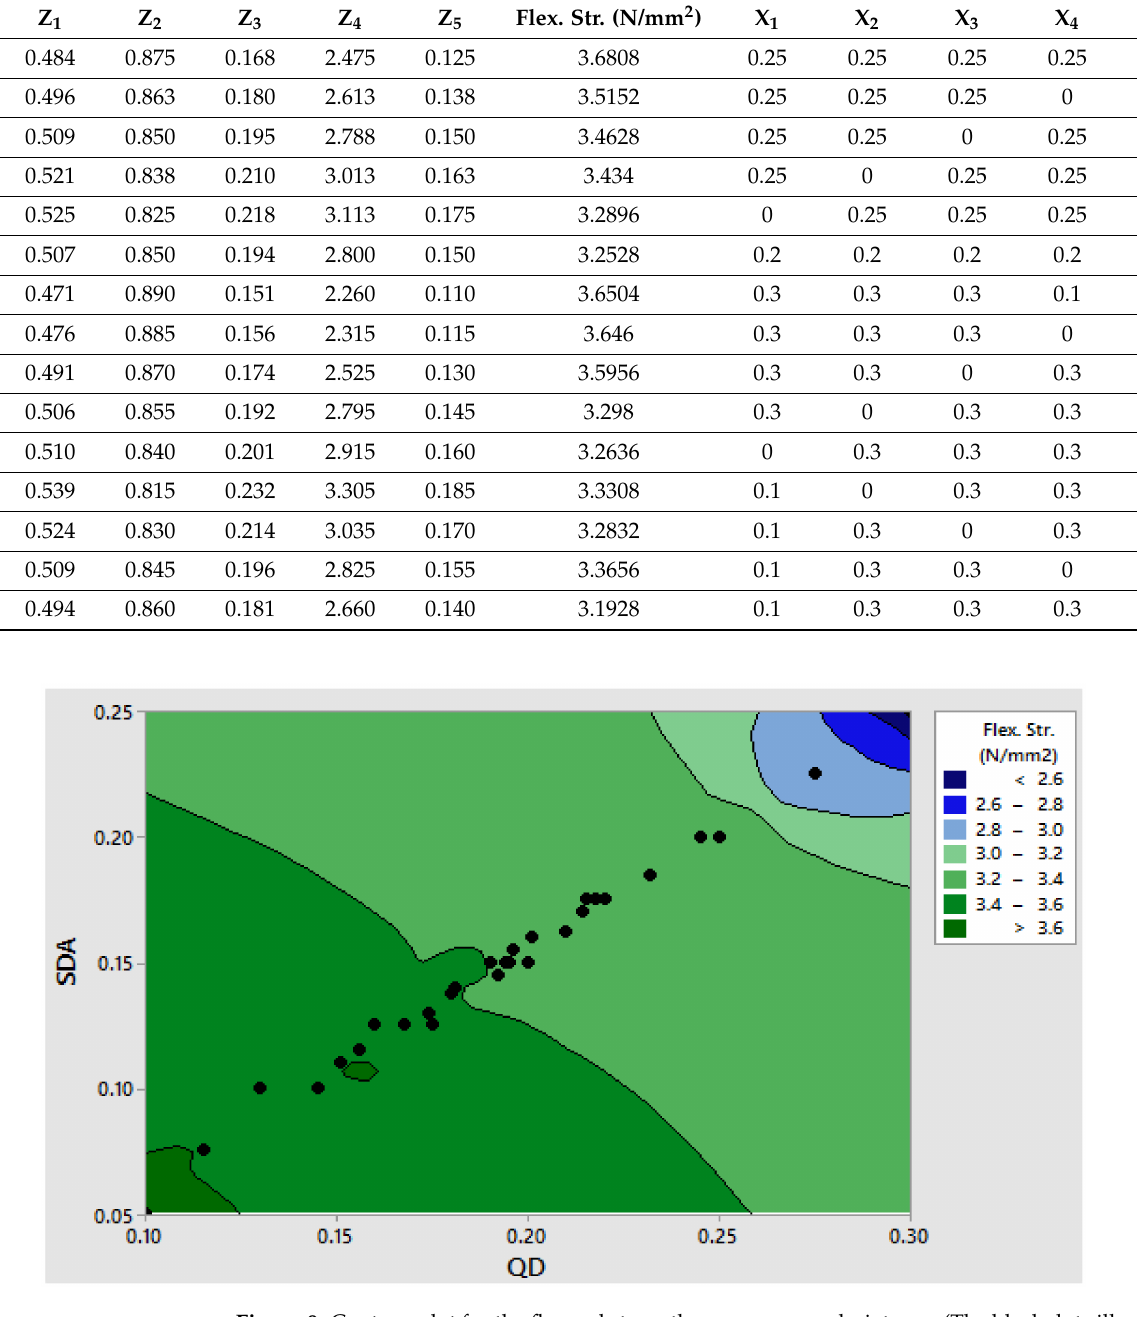
Figure 9. Contour plot for the flexural strength response vs. admixtures. (The black dots illustrate the regions in the legend where the points for the SDA and the QD factors meet. The response magnitude at those points are shown in the legend in varying color